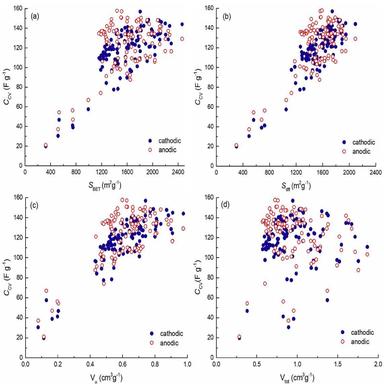
Specific capacitance (CCV) of CDC material vs. SBET (a), Sdft (b), Vm according DFT (c) and Vtot (d). (A colour version of this figure can be viewed online.)